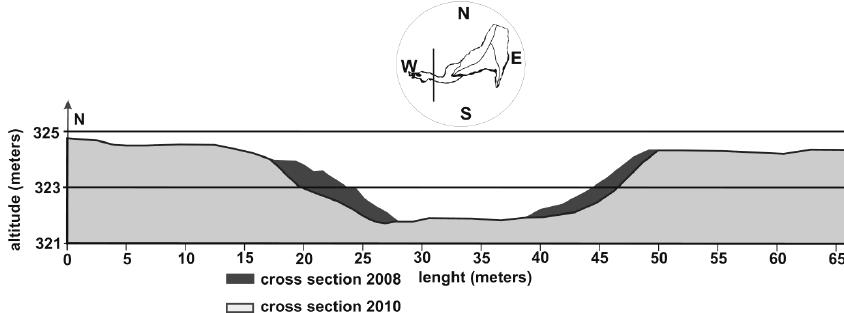
Fig. 13. Cross-section in the upstream of the main gullies.